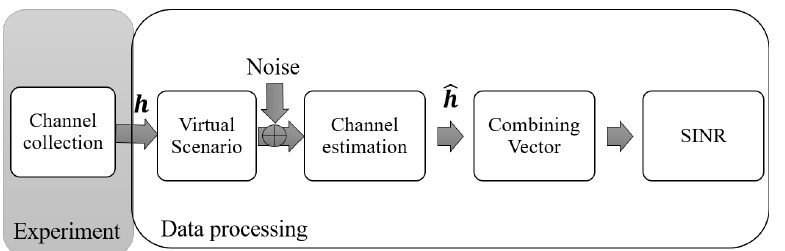
Figure 4. Sequence of the data collected during the ultra-dense experiment and its process